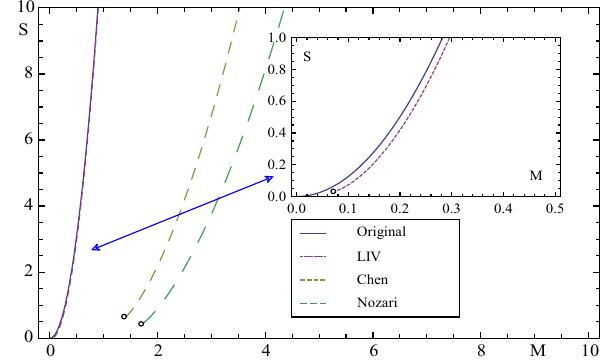
Fig. 7 The black hole’s modified entropy versus its mass when employing the GUP parameters β 0 = α = 1 and the LIV parameter ξ = 2